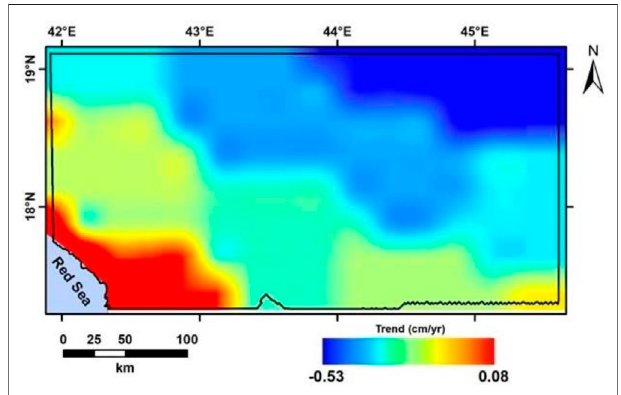
FIGURE 5 | Color-coded Δ TWS trend during the period 04/2002-12/ 2021from averaging of the CSR-M data.